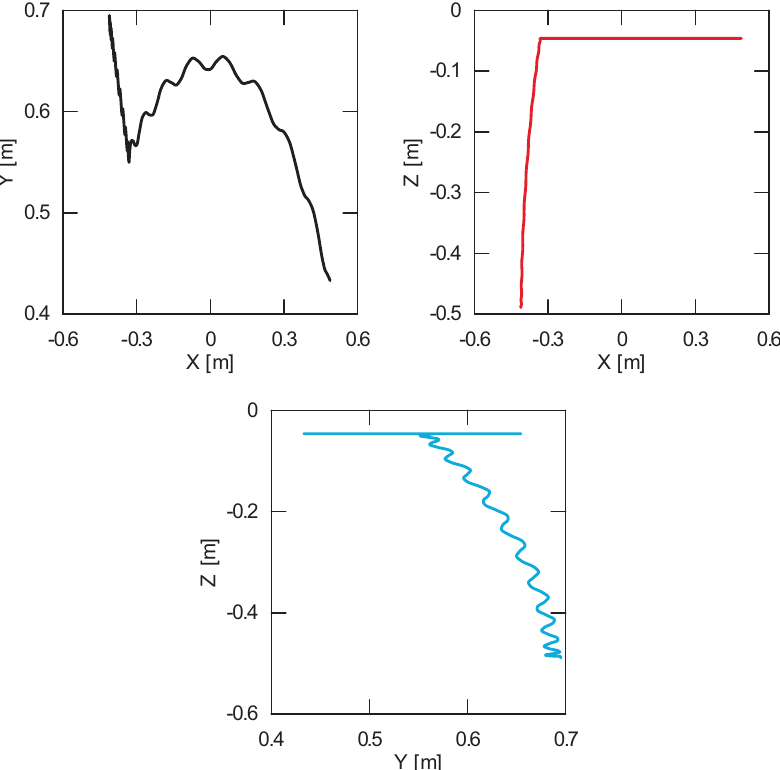
Figure 8. Projections of the trajectory of the carried load on the rotation and lifting